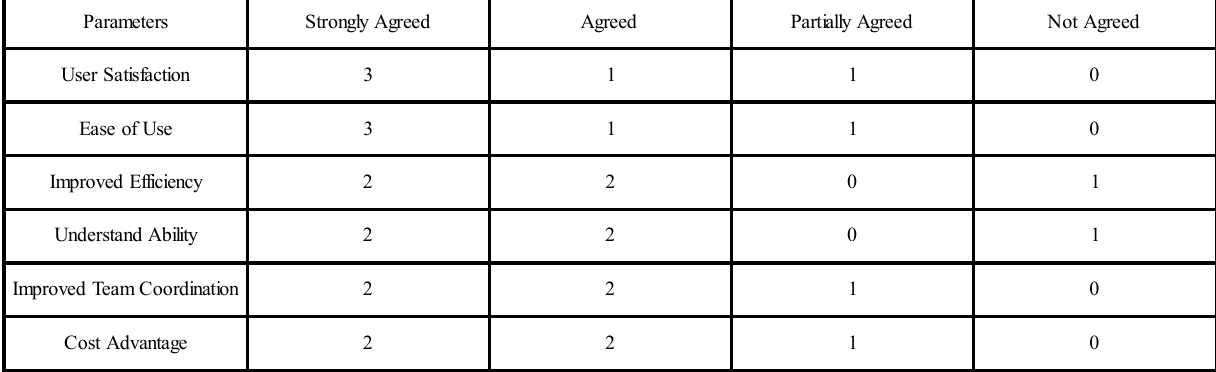
TABLE 2. TEAM COORDINATION (PROPOSED FRAMEWORK)